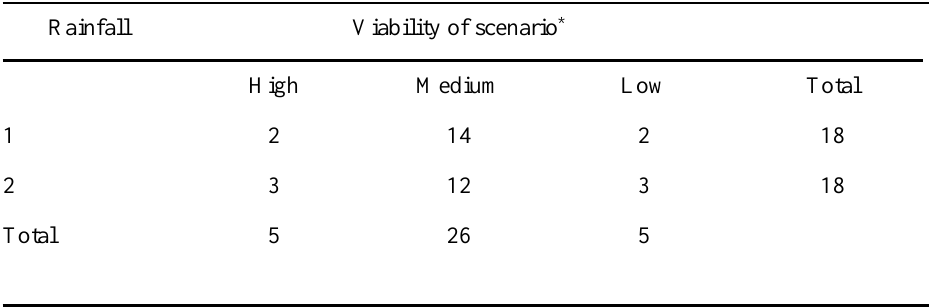
Table 7. Number of scenarios under different levels of viability based on two types of rainfall